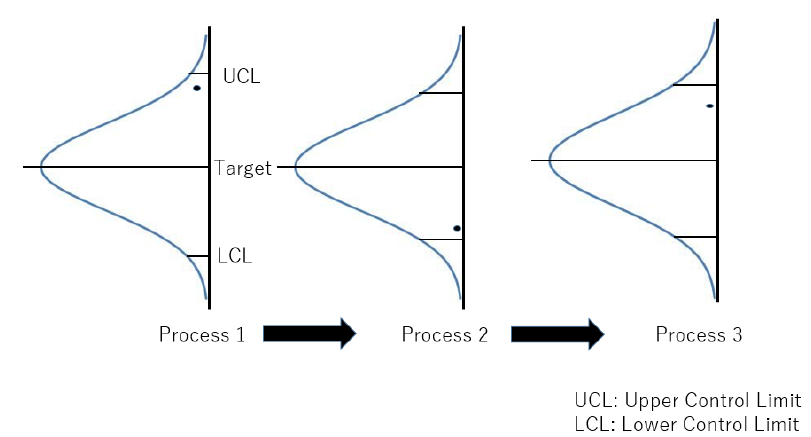
Figure 1. An example of tolerance settings in multiple